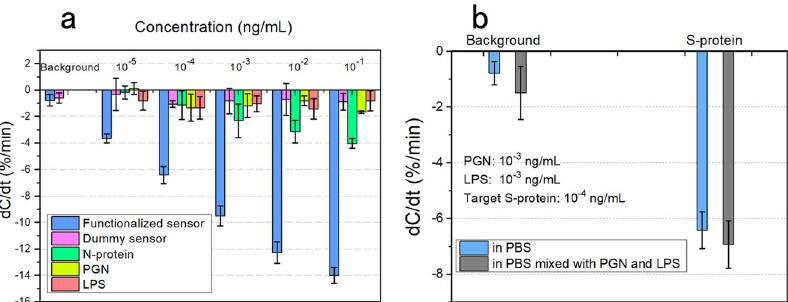
Fig. 4 Speci fi city veri fi cation of the immunosenors. a Speci fi city veri fi cation using different types of sensors and different analytes. The background is fi rst tested to verify the blank control and the sensor blocking effect. Functionalized sensors are compared with dummy sensors (also blocked with lactalbumin), to characterize the antibody functionalization. The control group contains nucleocapsid (N-) protein, peptidoglycan (PGN), and lipopolysaccharide (LPS). b Speci fi city veri fi cation in the hybrid medium. A hybrid medium is constructed by mixing PGN and LPS in 0.1× PBS solution. The PGN and LPS concentrations in 0.1× PBS are both 10 − 3 ng/mL, and the spiked S-protein is at 10 − 4 ng/ mL. In both ( a , b ), the error bar represents the standard deviation from three tests of the same sample using different sensors of the same